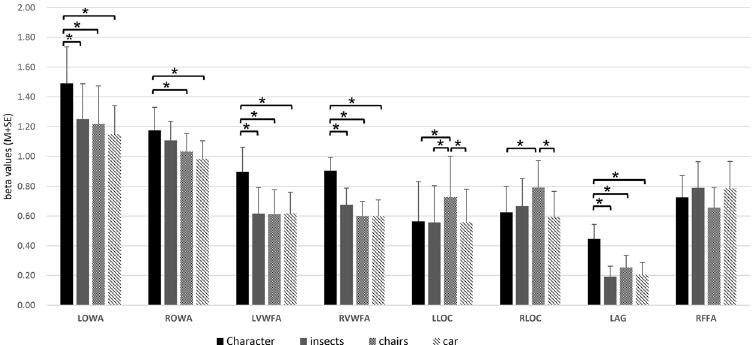
Figure 2. Summary of response amplitudes in the ROIs across subjects. The error bars denote the standard error calculated across subjects. The “ * ” indicates the mean difference is significant at the 0.05 level in the multiple comparisons and Sidak correction is applied. OWA shows similar selectivity pattern to character (words) as the VWFA. LOC, as control ROI, response to chairs strongest. (N = 10 for all the ROIs except that N = 8 for RVWFA, N: number of subjects) (the prefix “L” or “R” before each ROI name denotes left or